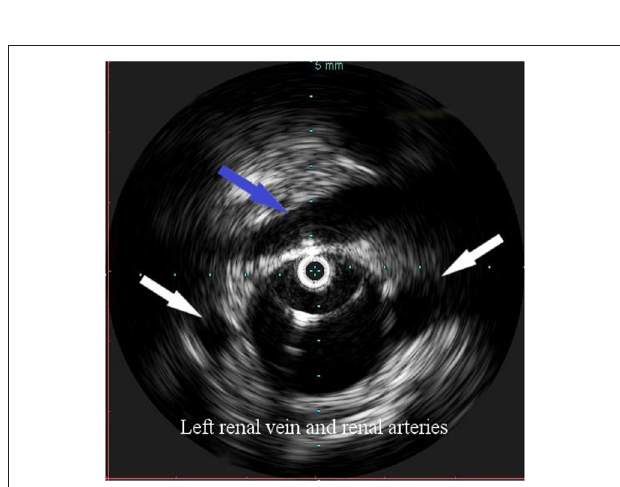
FIGURE 2 | Intravascular ultrasound (IVUS) identification of the ostia of renal arteries with the left one being lower (white arrows), in order to define the proximal landing zone of the graft. The left renal vein can be seen crossing the anterior aortic wall (arrow).